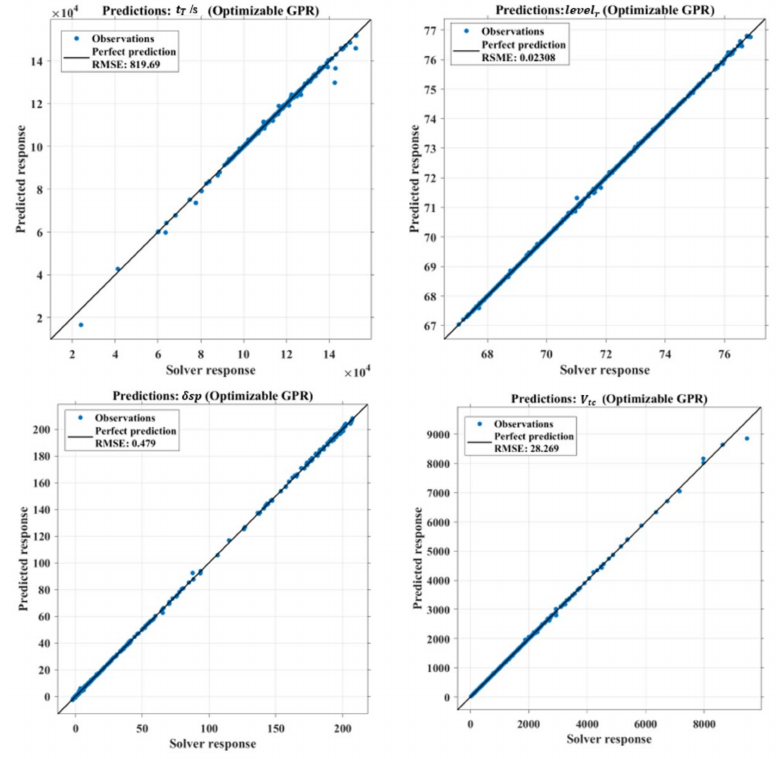
Figure 9. Final surrogate model